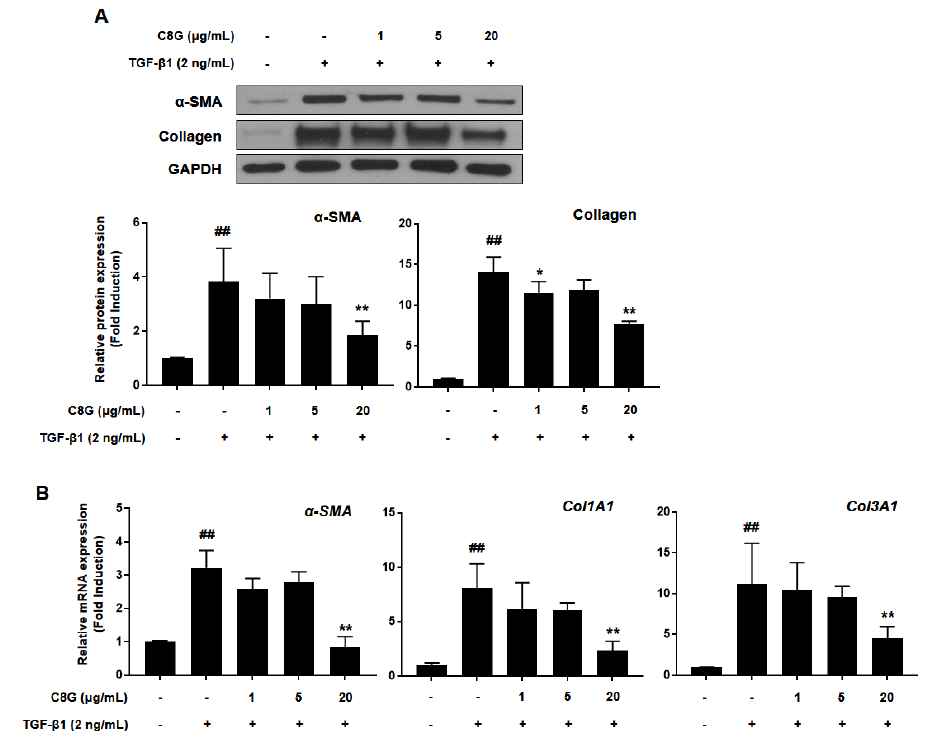
Figure 3. C8G suppressed the activation of LX ‐ 2 cells. Effects of C8G on LX ‐ 2 cell activation were tested by treating LX ‐ 2 cells with C8G for 48 h after activation by TGF ‐β 1 for 48 h. ( A ) The protein expression levels of α –SMA and collagen were analyzed by western blotting assay and quantified by Image J. GAPDH was used as a loading control. ( B ) The mRNA expression levels of α –SMA , Col1A1 , and Col3A1 were measured by qPCR analysis. Each experiment was conducted under the condition